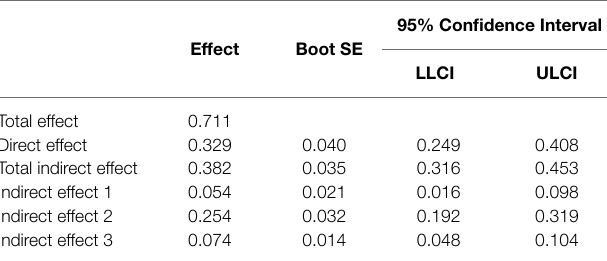
TABLE 4 | Effects and 95% confidence intervals for